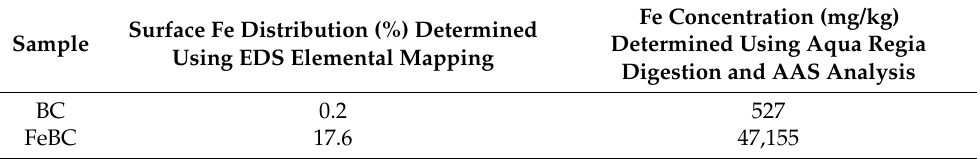
Figure 1. FE-SEM images and EDS elemental mapping results of BC and FeBC: ( a ) FE-SEM image of BC, ( b , c ) elemental mapping results of BC, ( d ) Fe-SEM image of FeBC, and ( e , f ) elemental mapping results of FeBC. Table 1. Elemental mapping results (% surface Fe composition) for BC and FeBC, and total Fe concentration analyzed via aqua regia digestion.